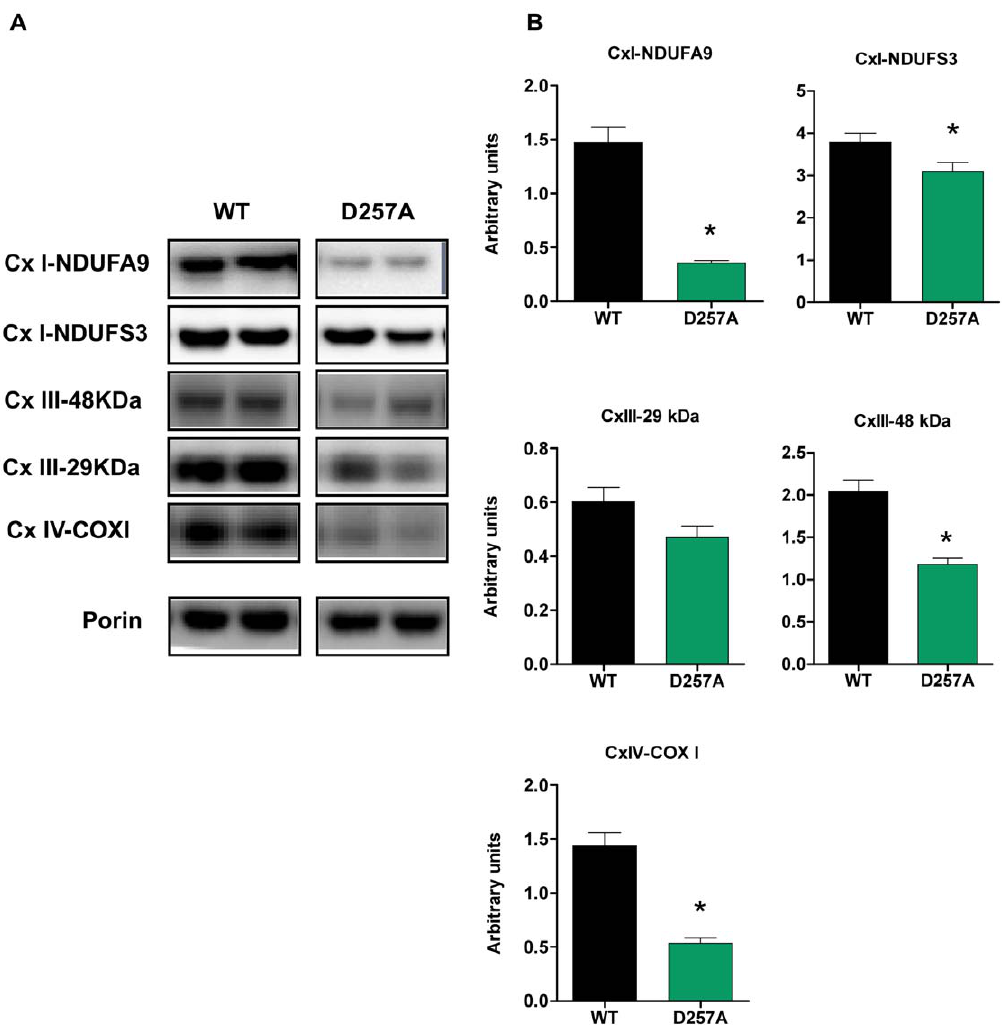
Figure 6. D257A mice show decreased protein expression of both nuclear-encoded and mitochondrial-encoded ETC subunits. (A) The content of selected nuclear-encoded (NDUFA9 and NDUFS3 subunits of Cx I, 29 kDa and 48 kDa subunits of Cx III), and mitochondrial-encoded subunits (COX I subunit of Cx IV) in skeletal muscle extracts of 11-mo old WT and D257A mice (n=11 per group) were evaluated by Western Blotting. Representative blots are depicted. (B) Statistical analysis of ETC subunits protein expression. Arbitrary units represent densitometry values normalized to porin. Mean values 6 SEM are shown. *p , 0.05. Cx: complex.